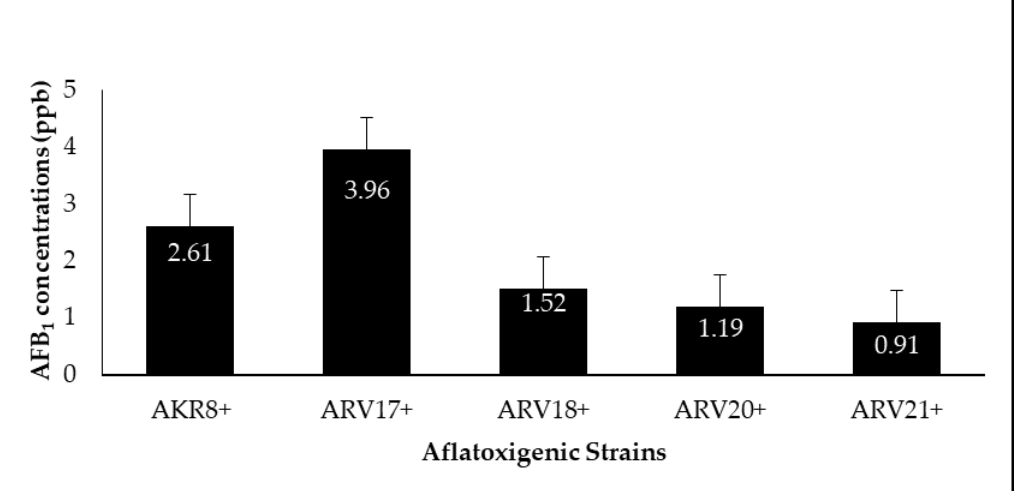
Figure 5. AFB 1 production by AF + strains following seven days of incubation.